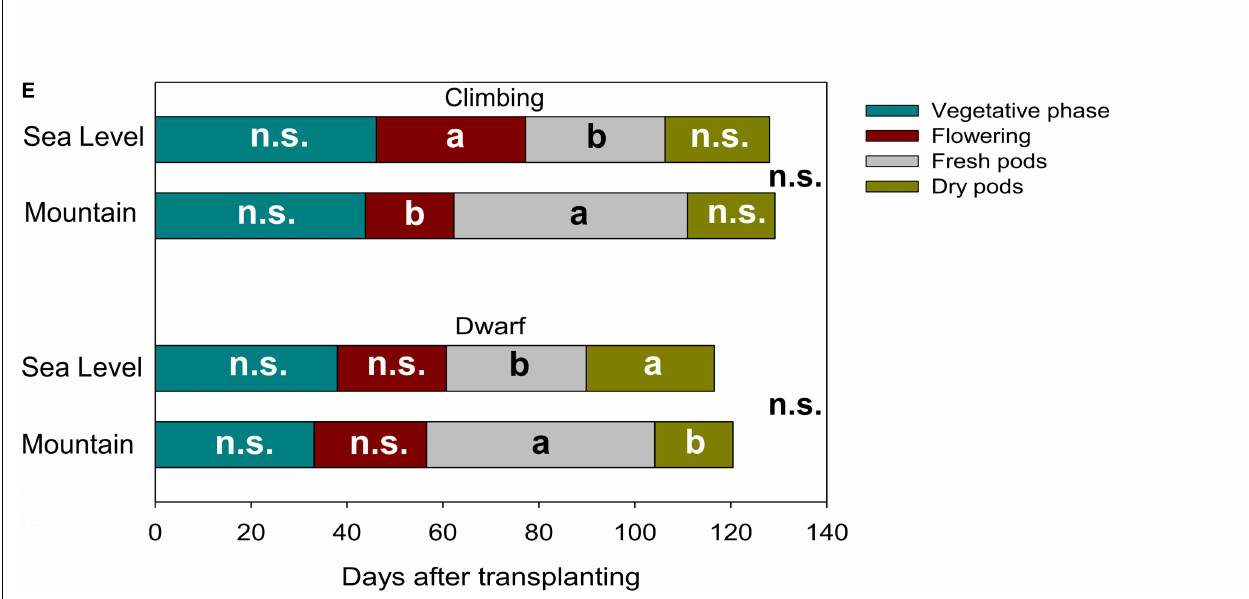
Frontiers in Plant Science |